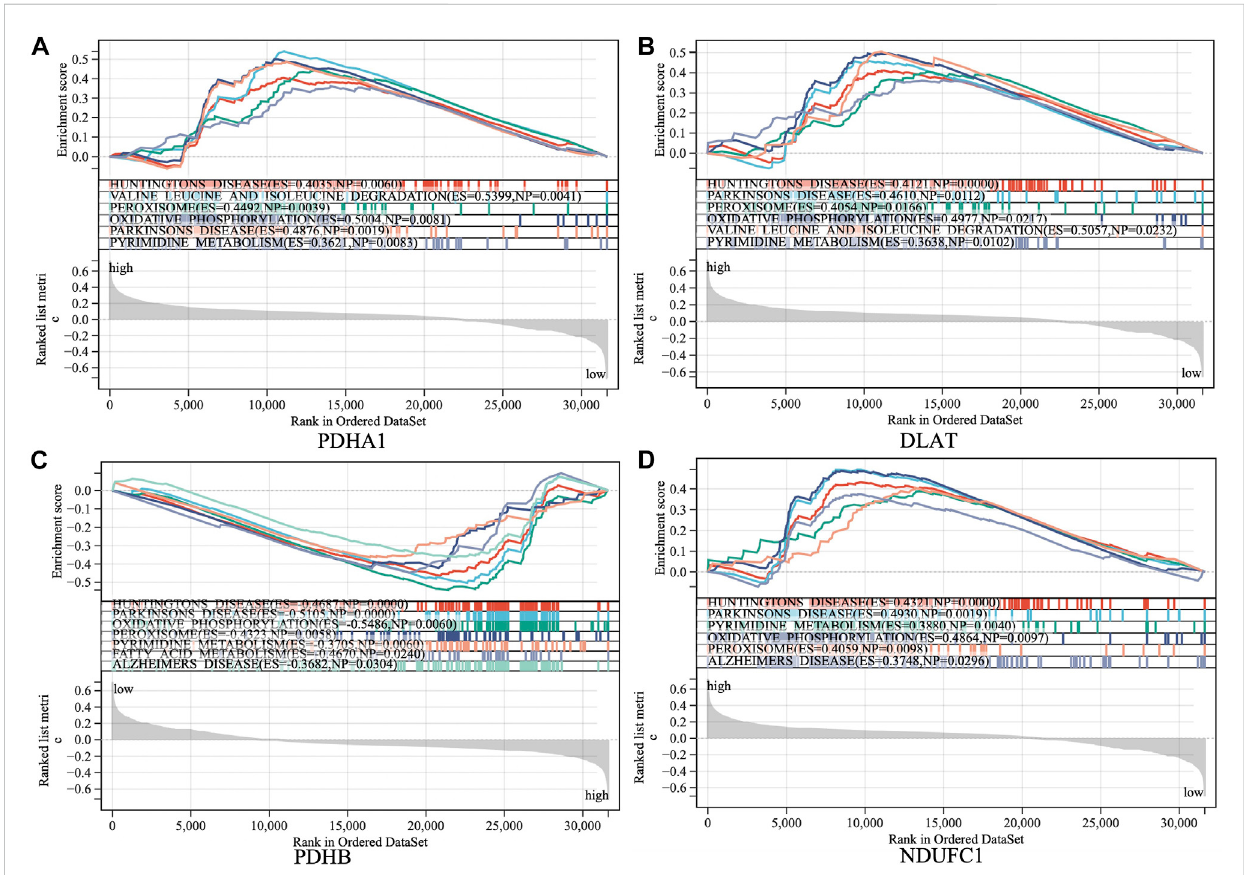
FIGURE 6 Gene set enrichment analysis (GSEA) to identify the enriched pathways of the central hub genes. (A) PDHA1; (B) DLAT; (C) PDHB; (D) NDUFC1.